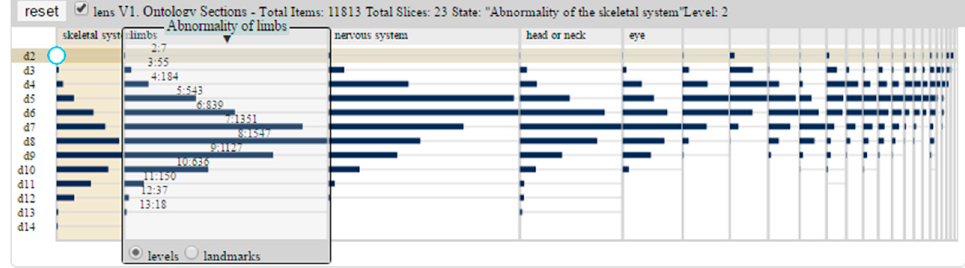
Figure 22. The result of a magic lens levels’ activation on the “Abnormality of Limbs” ontology section.